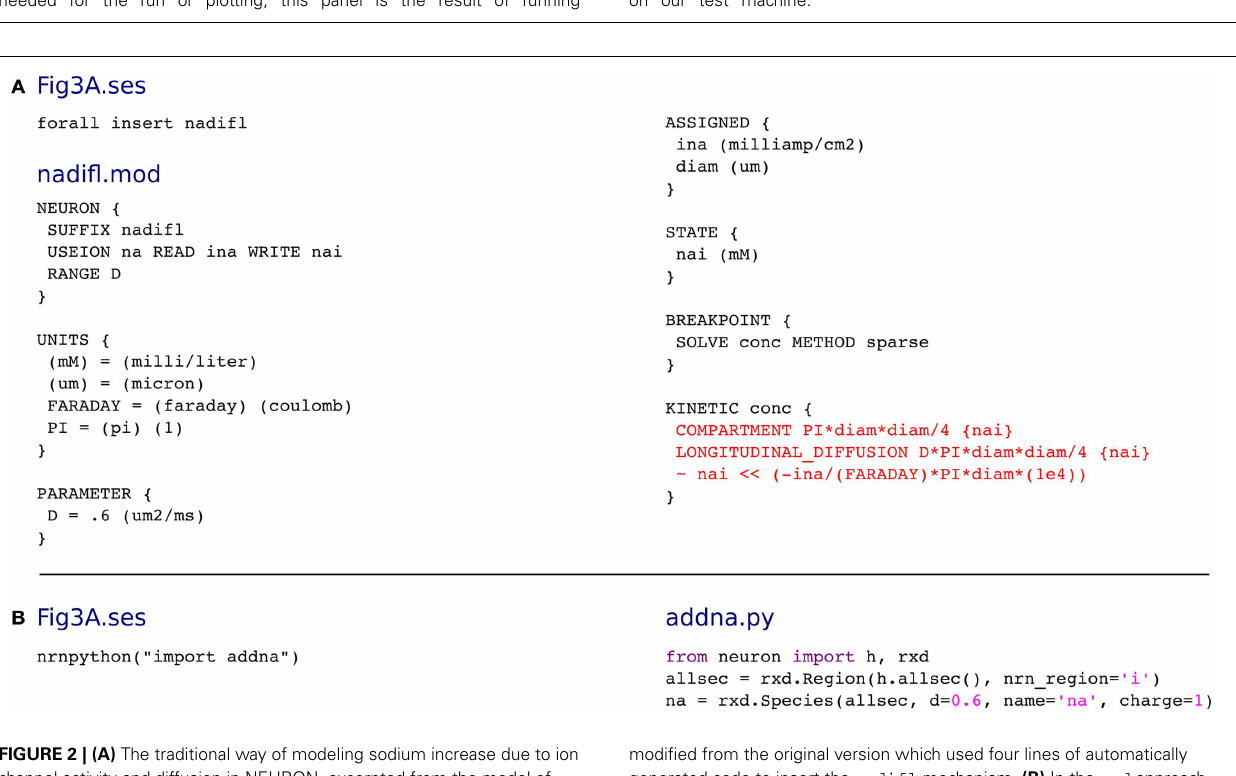
modified from the original version which used four lines of automatically generated code to insert the nadifl mechanism. (B) In the rxd approach, the code is shorter and clearer as less connectivity code is needed and as rxd automatically handles ion influx and the effects of geometry on